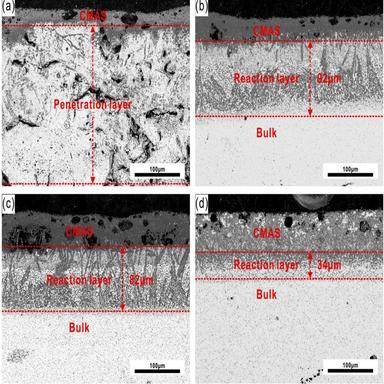
Cross-sectional backscattered electron SEM images of (Y1-xLax)3Al5O12 samples after CMAS corrosion at 1250 ◦C for 5 h: (a) x = 0, (b) x = 0.1, (c) x = 0.2, (d) x = 0.3.